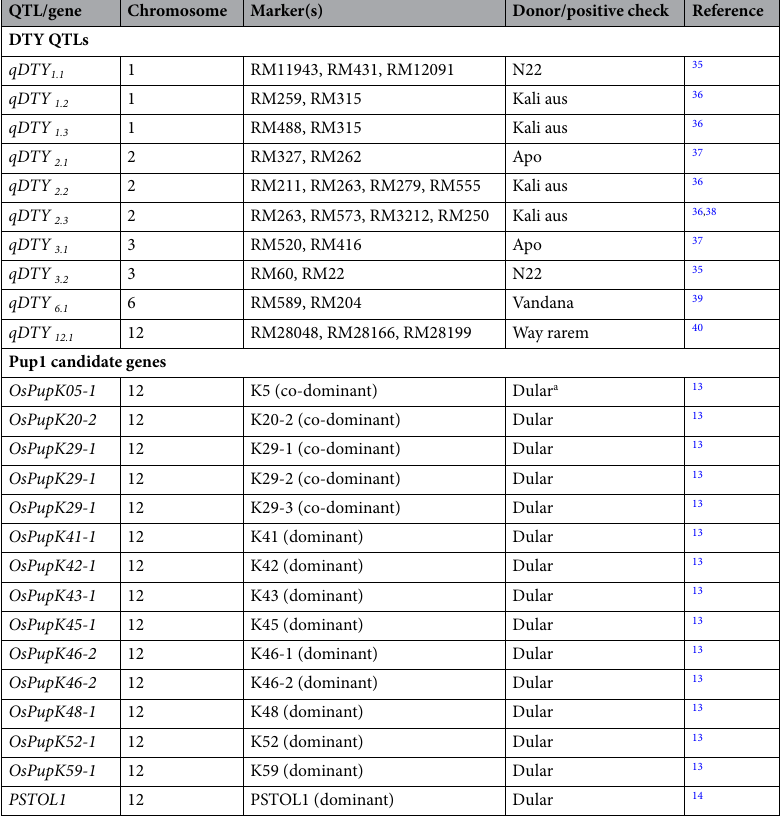
Table 1. Markers used in the study. a Dular has been taken as positive check in the present study for Pup1 genotyping. Dular and Kasalath (original donor of Pup1 ) had similar alleles for all the gene models at Pup1 locus Chin et al. 13